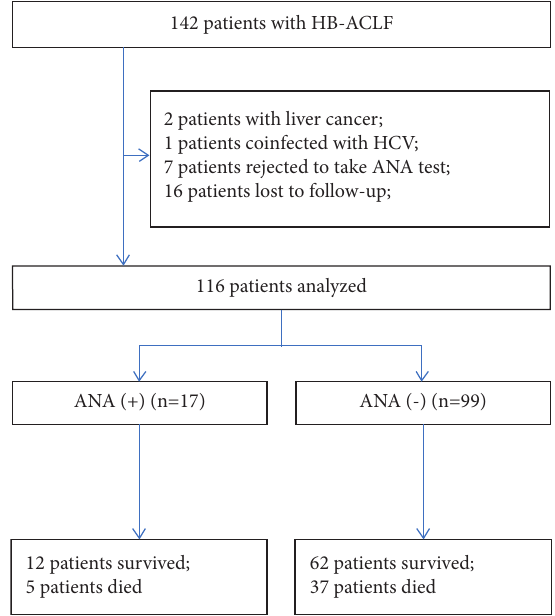
Figure 1: Screening of patients with acute-on-chronic liver failure and positive antinuclear